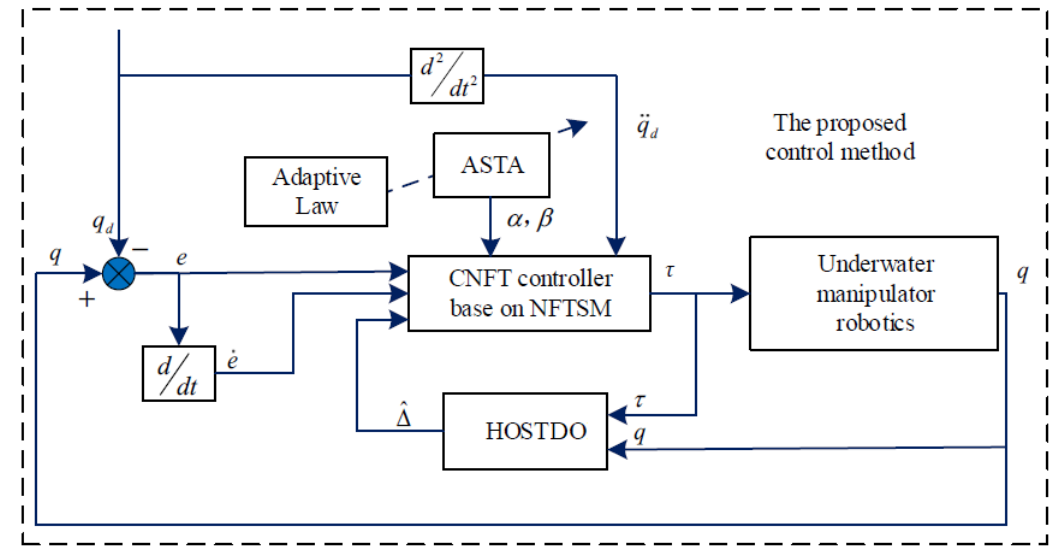
Figure 1. Block diagram of the proposed control